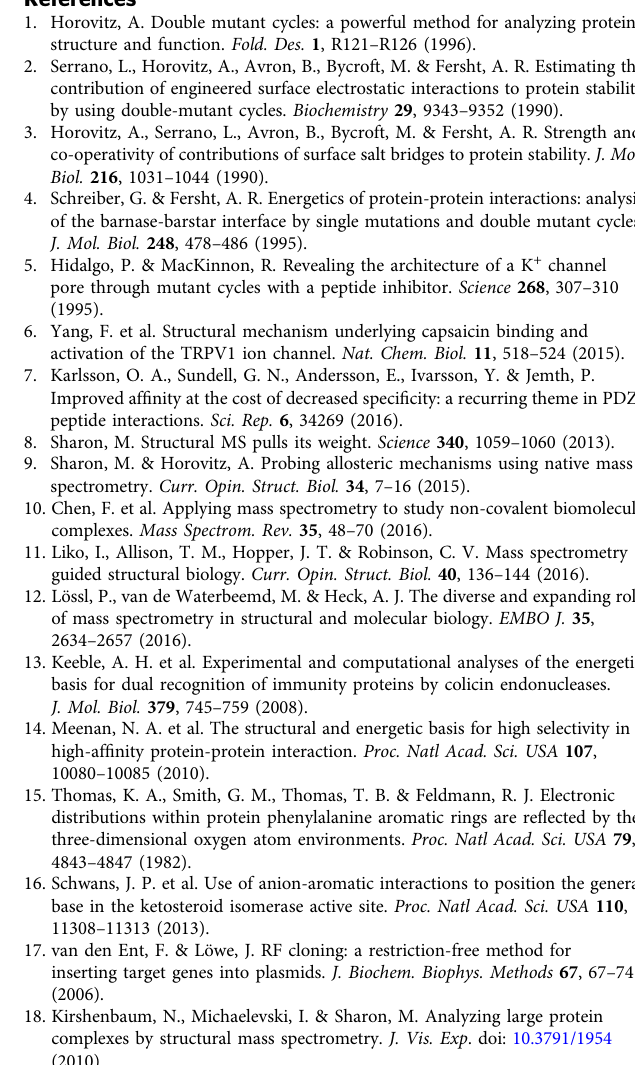
concentration of wild-type Im2 is doubled relative to the other three proteins (see Supplementary Fig. 3). Hence, it was possible to assign the peak at 2889 m/z to